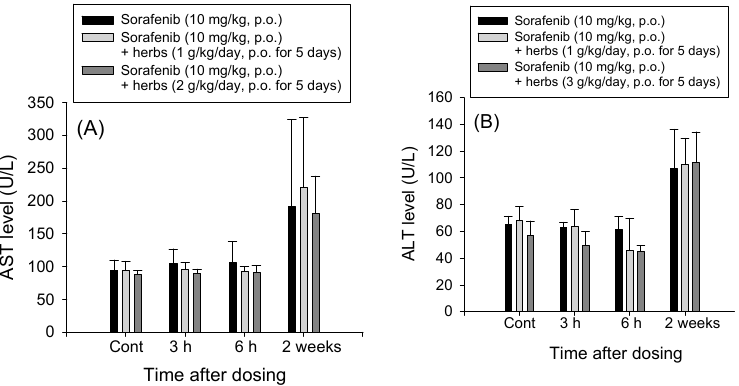
Figure 3. ( A ) AST and ( B ) ALT levels in rat plasma after the oral administration of sorafenib (10 mg/kg, p.o.), co-administration of LDXGT formulation (1 g/kg/day, p.o.) and sorafenib (10 mg/kg, p.o.) and co-administration LDXGT formulation (2 g/kg/day, p.o.) and sorafenib (10 mg/kg, p.o.). Blood samples were collected at 0, 3 and 6 h after the administration of the single sorafenib dose and two weeks later after the repeated administration of the dosage